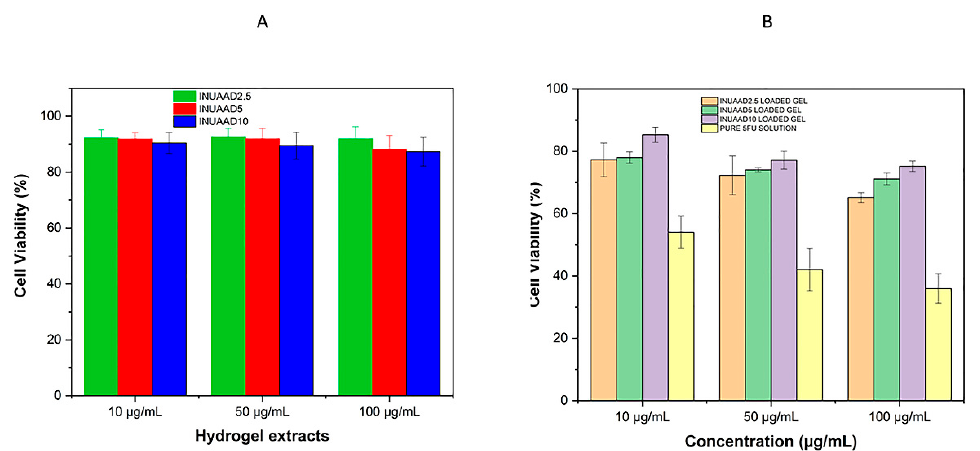
Figure 8. ( A ) Cell viability of the HCT116 cancer cells after treatment with the blank hydrogel extracts, and ( B ) cell viability of HCT116 cancer cells after treatment with the 5FU-loaded hydrogel extracts.